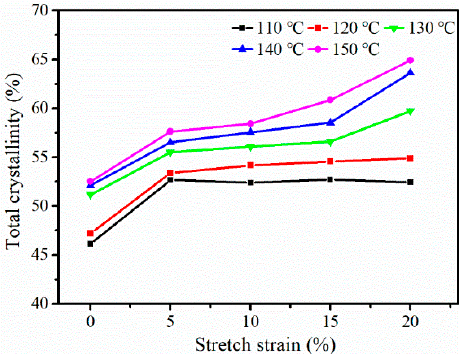
Figure 4. Total crystallinity of the iPP sheet after stretching at different temperatures.